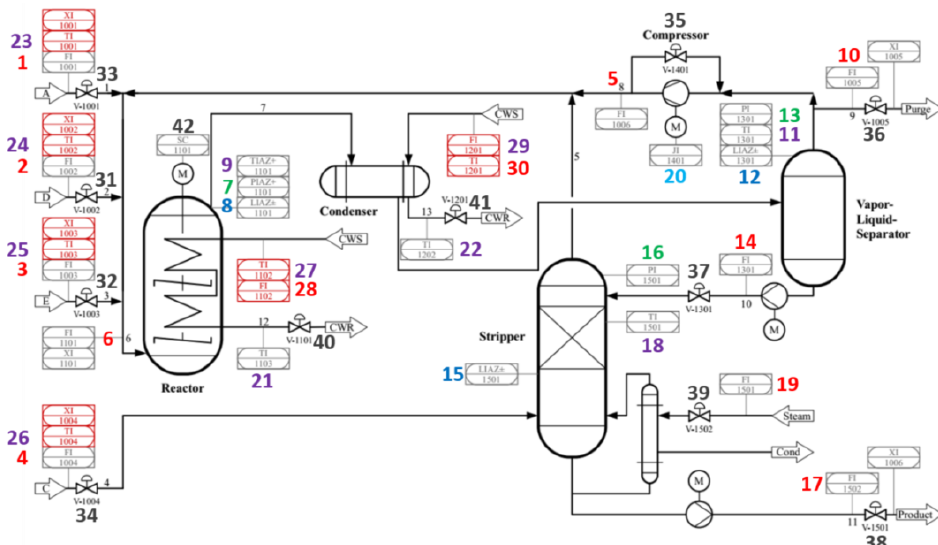
Figure 7. The process flow diagram of TEP simulation.